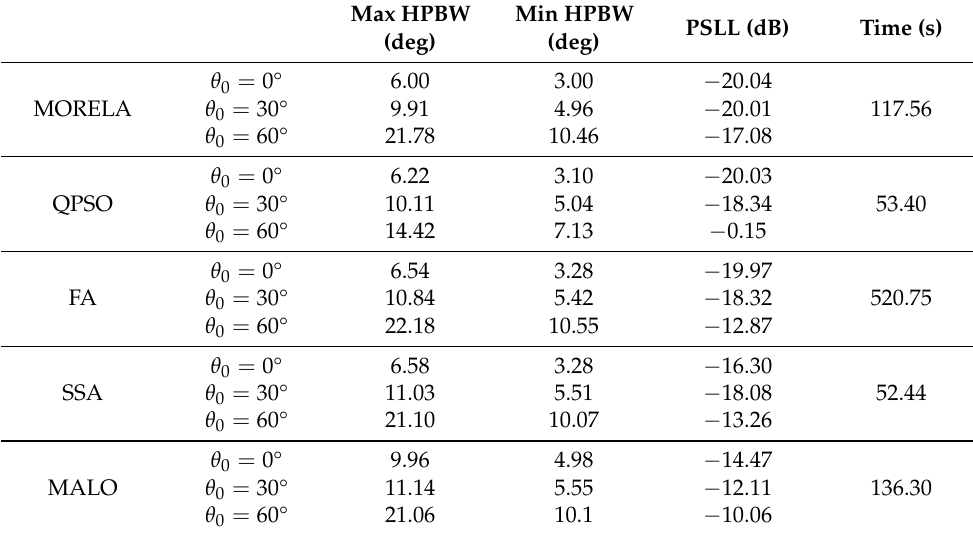
Table 4. Performance comparison for asymmetric NUSLA.